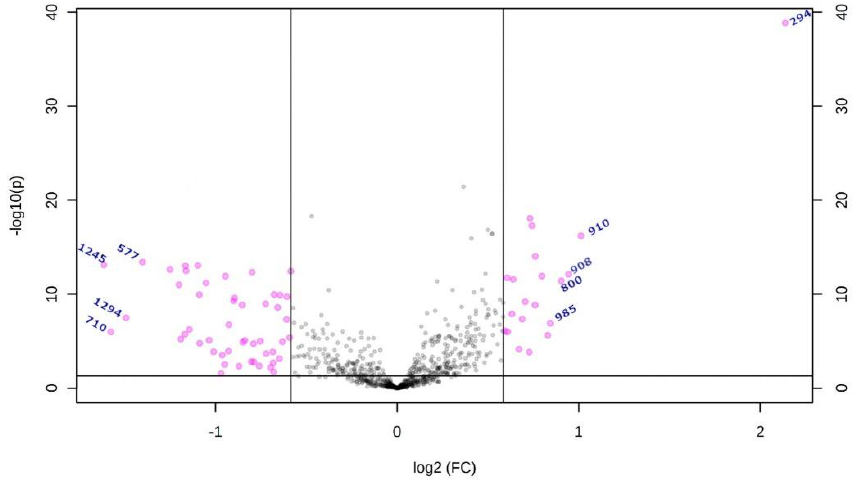
Figure 2. Volcano plot and statistical analysis of the detected metabolites. The m / z values of metabolites with p < 0.05; fold change (FC) ≥ 1.5; Log 2 (FC) ≥ 0.585 were selected (pink dots). The gray dots correspond to m / z values that does not fit in p and FC threshold